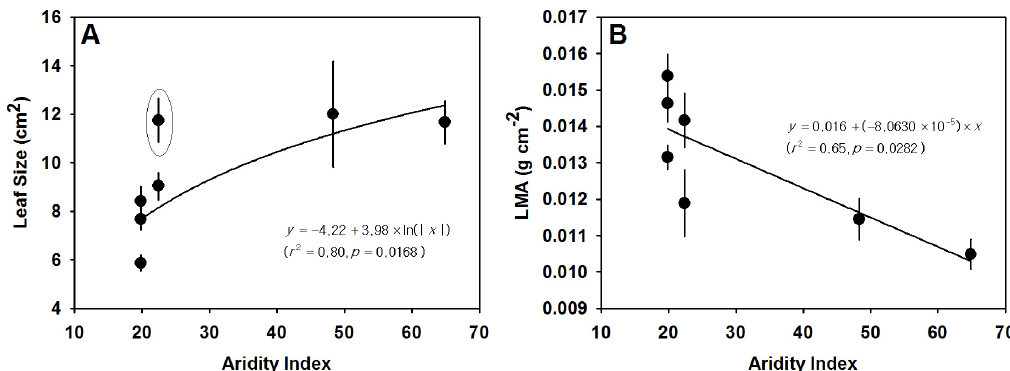
Figure 4. Comparison of the leaf characteristics from seven sampling sites. ( A ) Individual leaf size (cm 2 ). The line indicates logarithmic regression of leaf size (cm 2 ) based on the aridity index. The error bar is one standard error. The statistics were calculated excluding the circled site; ( B ) Leaf mass per unit leaf area (g ∙ m − 2 , LMA). The line indicates the linear regression of the LMA (g ∙ m − 2 ) based on average annual precipitation.